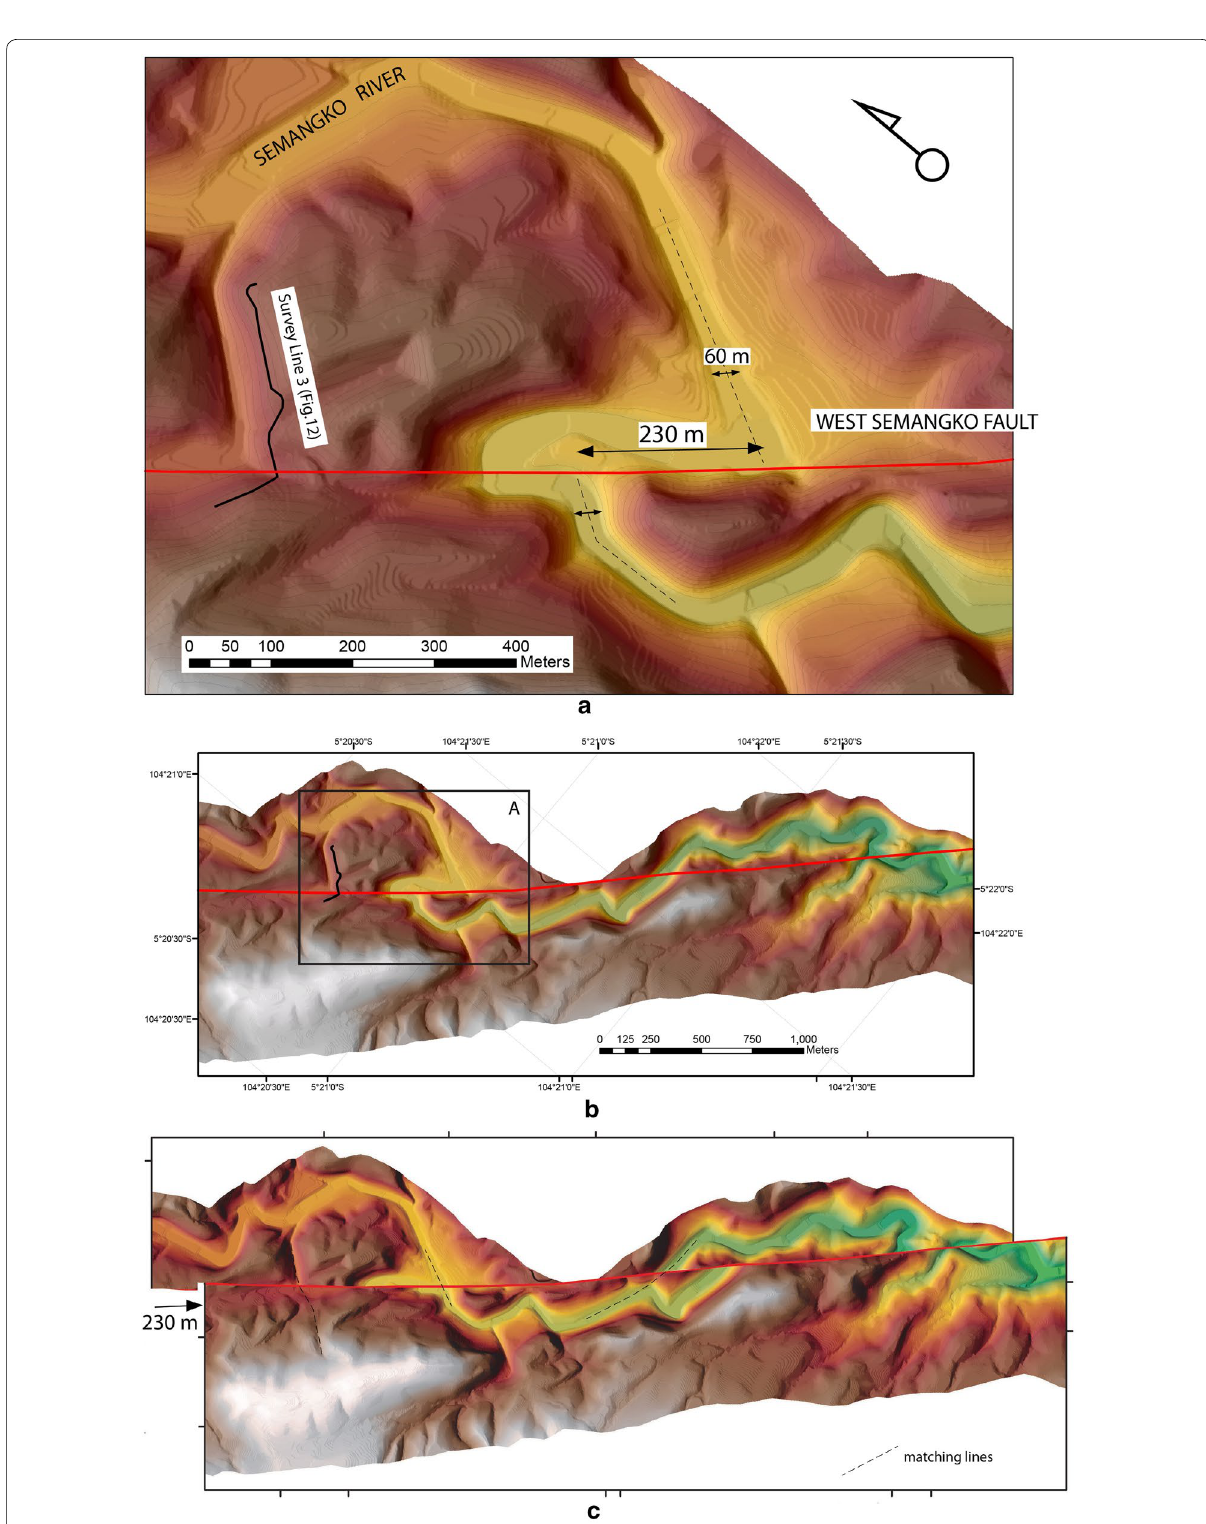
Fig. 13 a , b Single right-lateral offset of the Semangko River where it crosses the main active trace of the West Semangko Fault, south of Suoh (location is marked at Fig. 3). Channel incision at this site postdates eruption of the Ranau Tuff. The high-resolution digital terrain is developed from local topographic contour map for the Hydroelectric plan constructions. c Restoration of old topography before 230 m right-lateral movement. Slip rate is 6.8 1.8 mm/year taking into account the width of the river valley (~60 m) as the uncertainty of ±